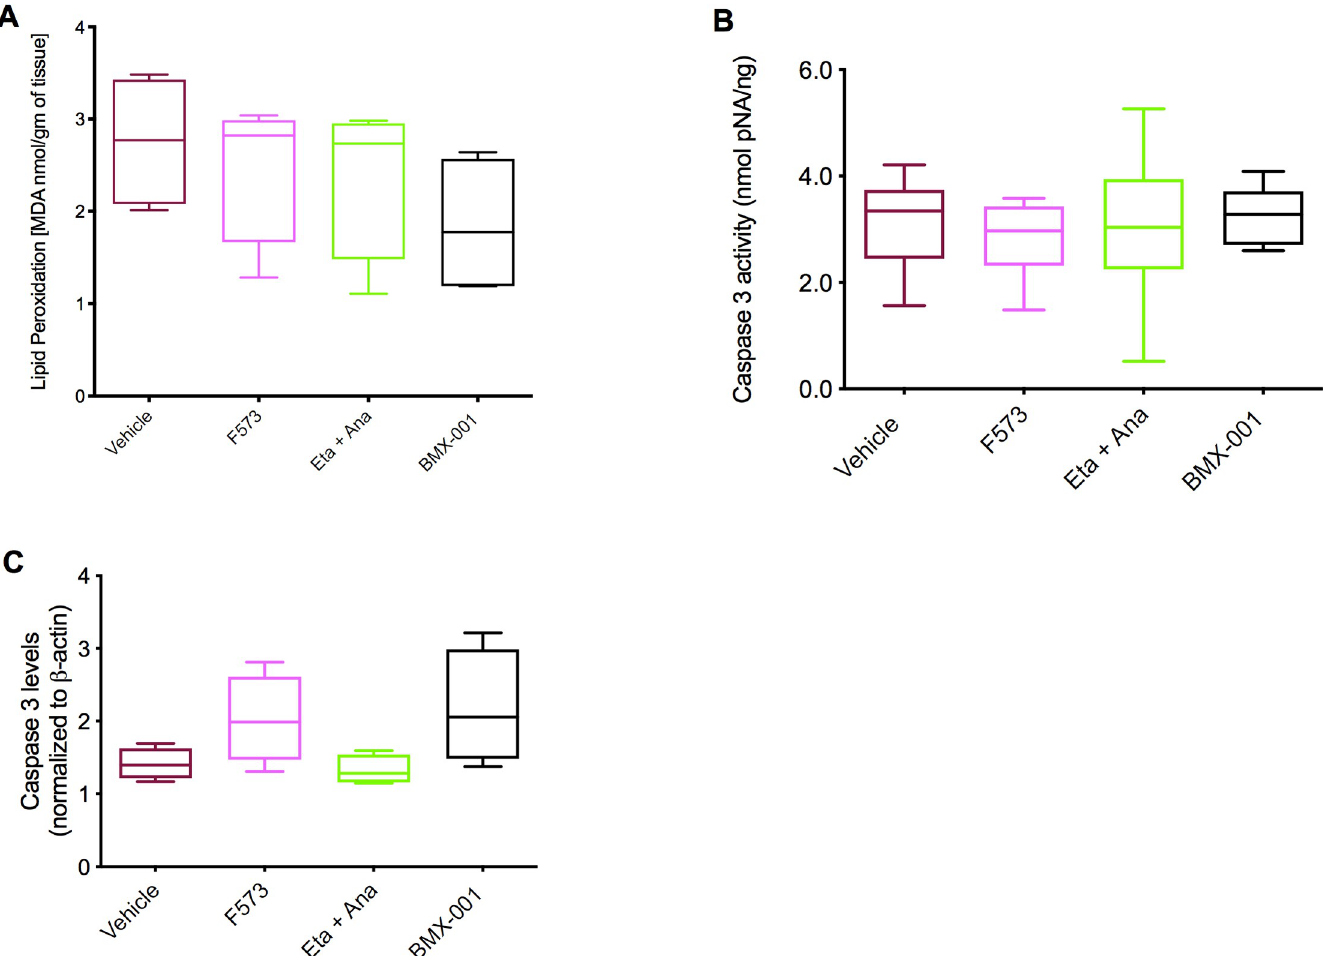
Fig 4. Reactive oxygen species quantification and caspase-3 activity. A. Oxidative stress quantified by lipid peroxidation malondialdehyde (MDA) assay (p = 0.45) (B) Caspase-3 activity determined by comparison to the standard curve of p NA (p = 0.84), (C) Caspase-3 protein level quantification normalized to ß-actin from western blot (p = 0.10). Data columns show means and SEM, 95% confidence interval (n = 4, 6, and 4, respectively per group).